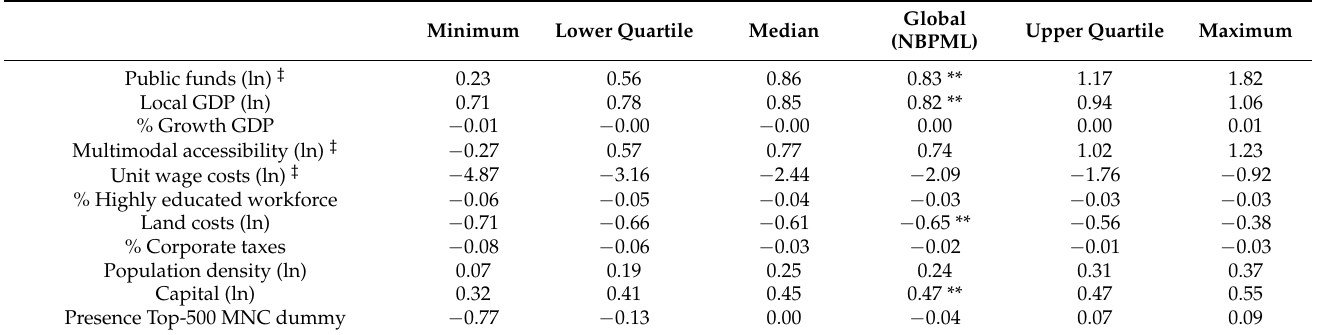
Figure 5. Spatial Variation in Coefficients of Public Funds: Production Plants. Table 7. Geographically Weighted Negative Binomial Regression Estimates—Production Plants.